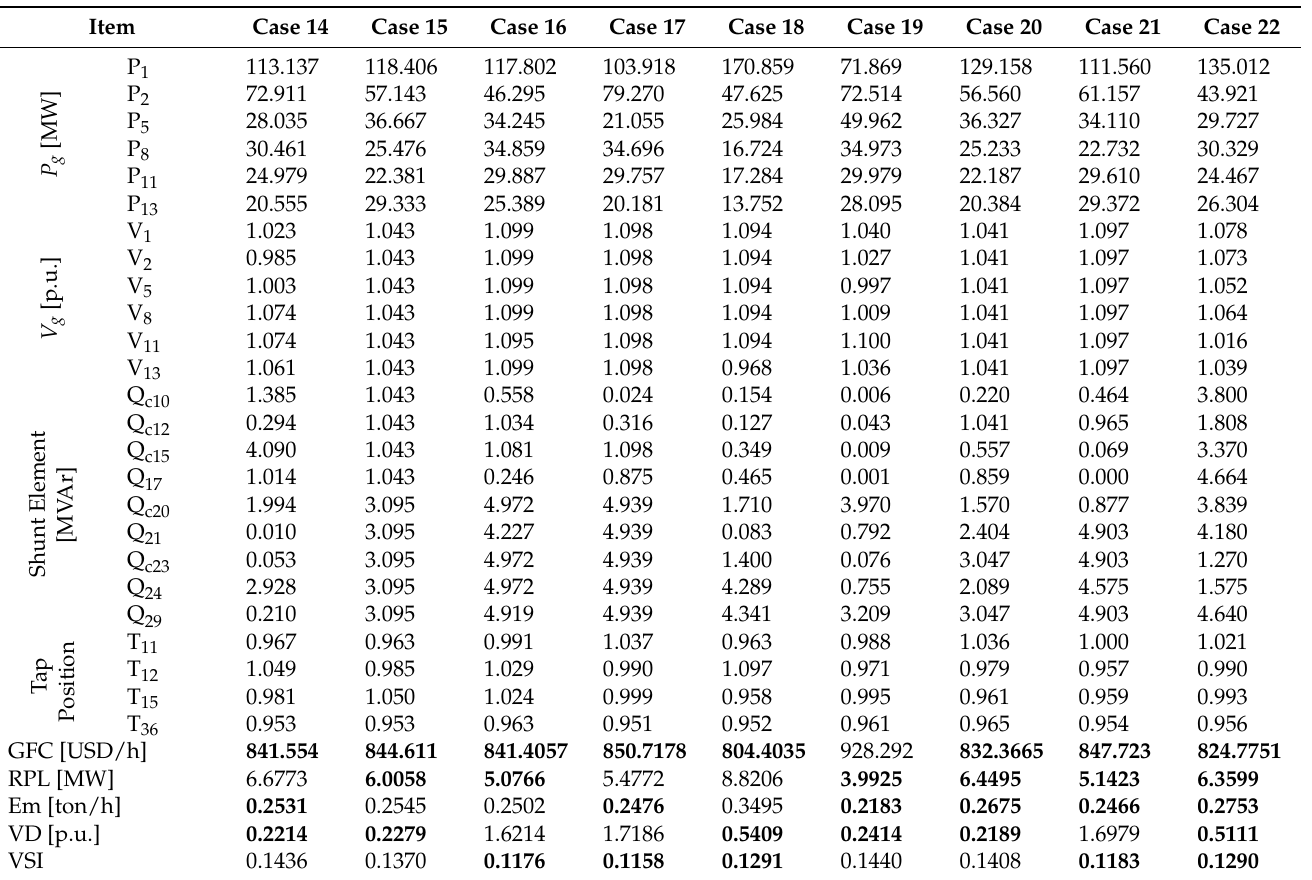
Table 7. Optimal control variables obtained by MOSMA for Cases